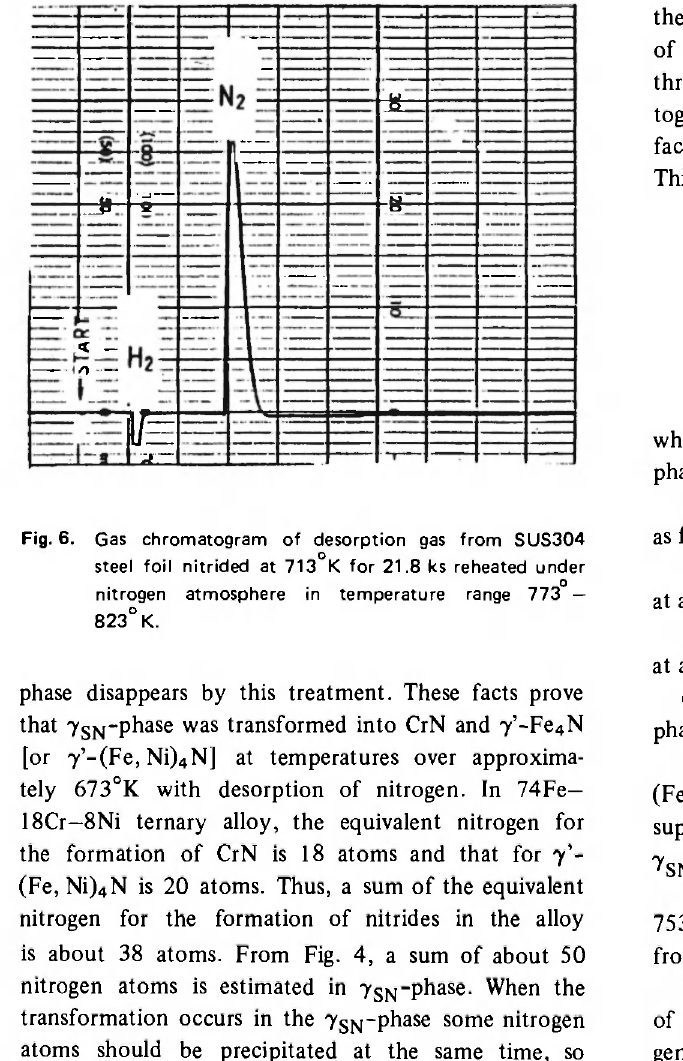
Fig. 6. Gas chromatogram of desorption gas from SUS304 steel foil nitrided at 713°K for 21.8 ks reheated under ο nitrogen atmosphere in temperature range 773 — 823° K.